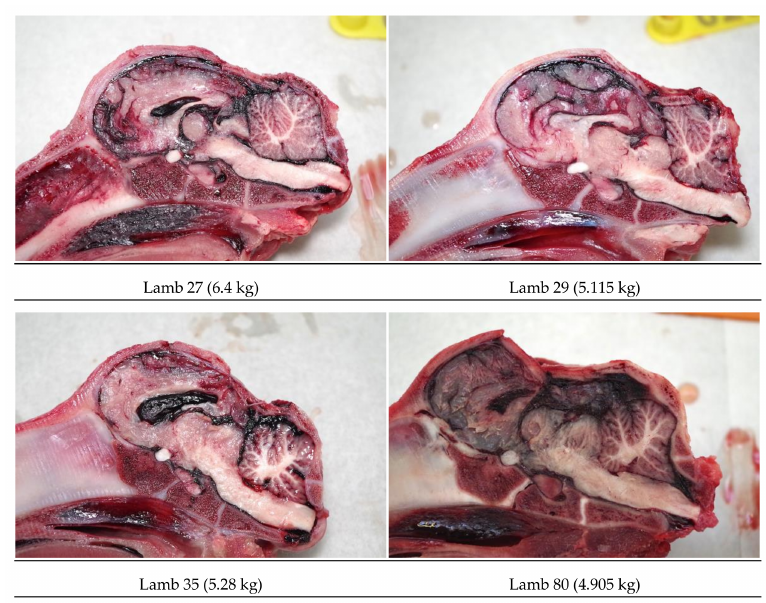
Figure 8. Examples of post-shot trauma, medial sagittal section.